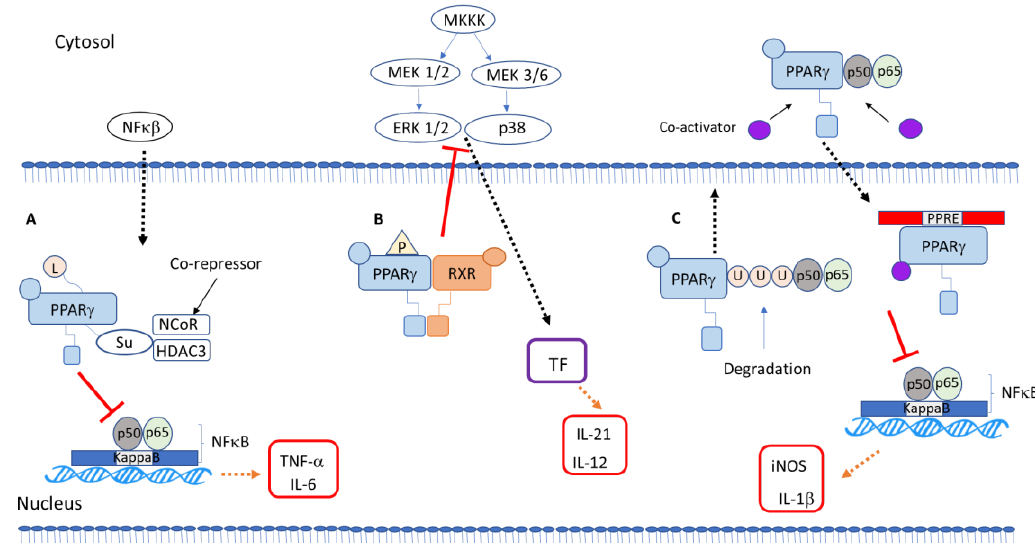
Figure 1. Molecular regulatory mechanisms of PPARγ. ( A ) A ligand-dependent transrepression. Binding to PPARγ ligand leads to SUMOylation of PPARγ, which stabilizes the co-repressor, leading to blockade of NFκB target gene expression. ( B ) Non-genomic role of PPARγ. PPARγ phosphorylates MAP kinase, leading to inhibition of transcription factor (TF) binding. ( C ) Transrepression. ubiquitination of PPARγ increases its stability, and it can also inhibit NFκB target genes. PPARγ (peroxisome proliferator-activated receptor γ), small ubiquitin-like modifier (SUMO)ylation, NFκB (nuclear factor kappa B).